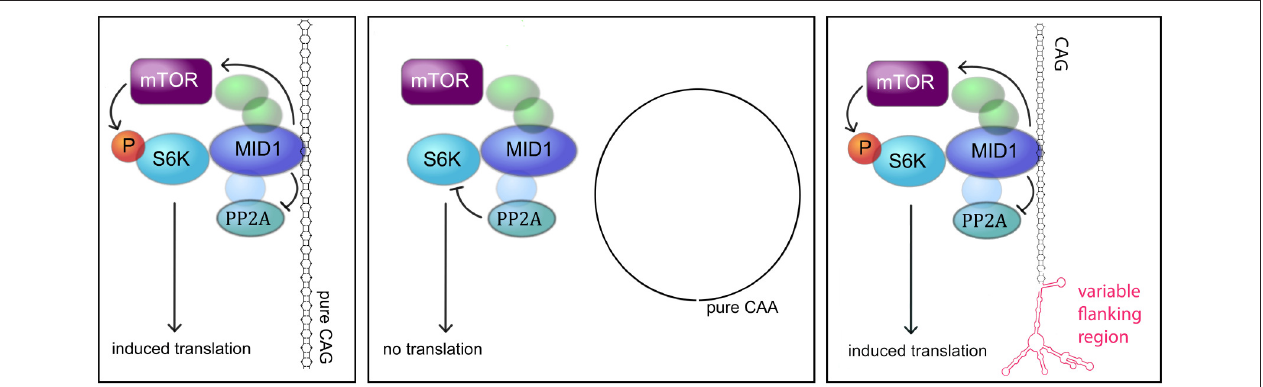
FIGURE 6 | MODEL. Model showing the interaction between the MID1 complex and CAG repeat mRNAs (adapted from Nalavade et al., 2013). The MID1 complex binds to CAG repeats independent of its flanking region and recruits its binding partners, including S6K to the RNA. S6K is a translational regulator with phospho-dependent activity that is regulated by PP2A and mTOR. MID1 not only acts as a scaffold bridging the binding between mRNA and S6K, but it also regulates the activity of PP2A and mTOR. Thereby, MID1 is able to induce translation of mRNA.